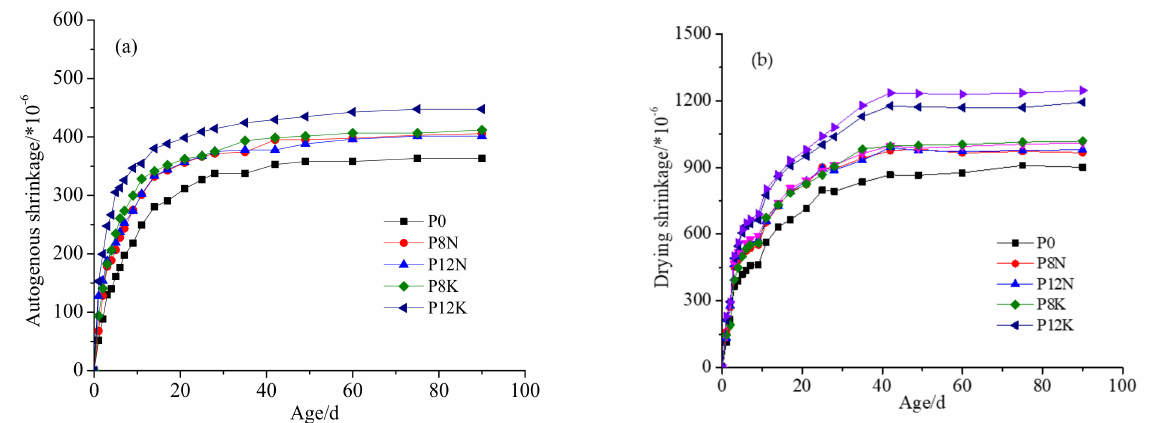
Figure 4. Shrinkage of OPC mortars with different alkali sulfates contents. ( a ) Autogenous shrinkage; ( b ) drying